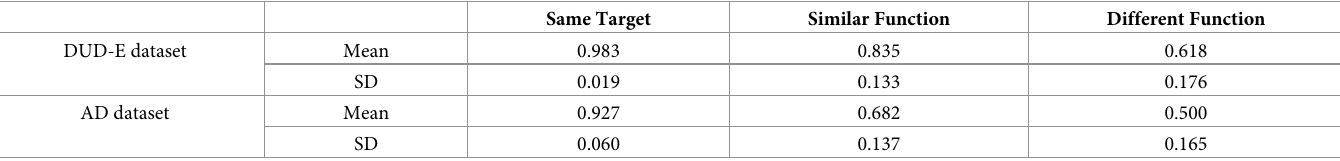
Table 3. The mean and SD of the AUC values across three target